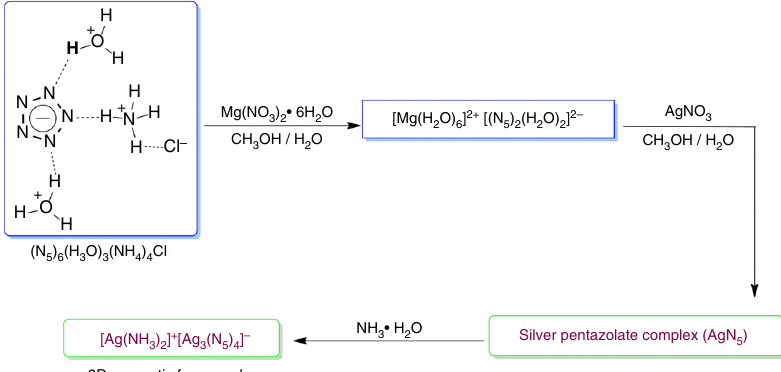
Fig. 1 Syntheses of the silver pentazolate (AgN 5 ) complex and [Ag(NH 3 ) 2 ] + [Ag 3 (N 5 ) 4 ] ˉ . Synthesis of AgN 5 contains two steps by salt metathesis: The First-step of removing the non-energetic Cl ˉ and the second step of eliminating the H 2 O